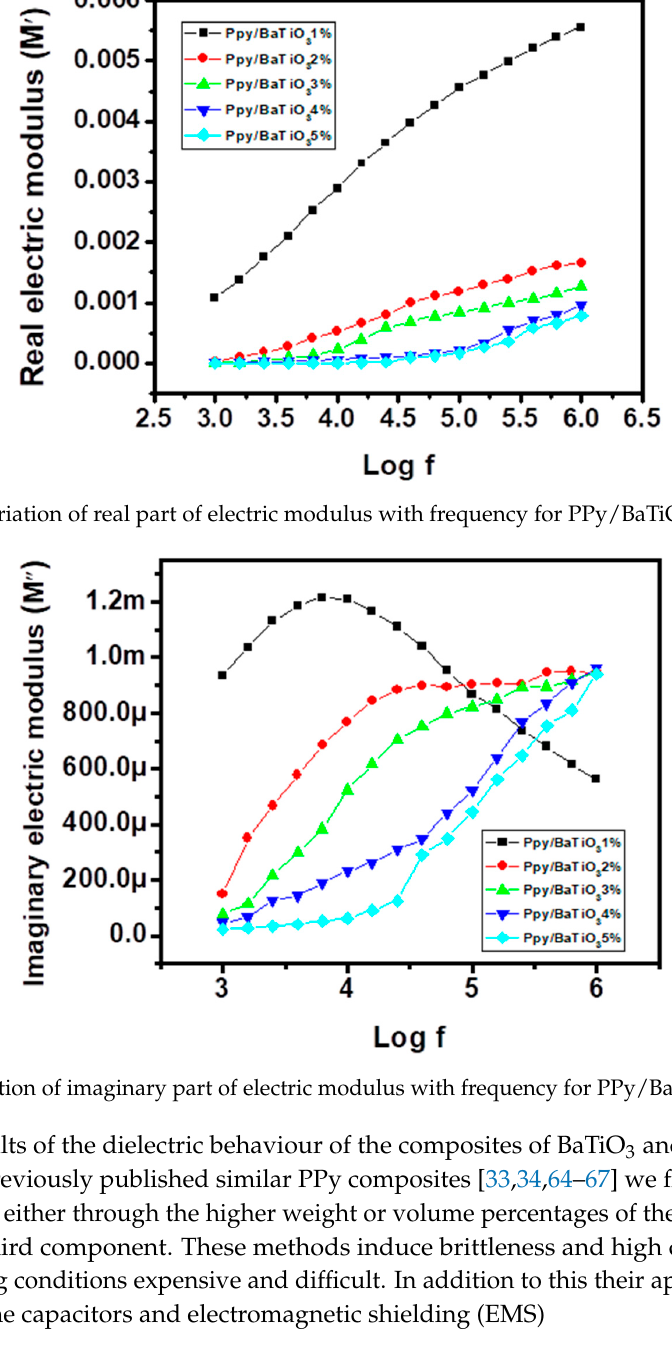
Figure 12. Variation of dielectric loss with frequency for PPy/BaTiO 3 composites.